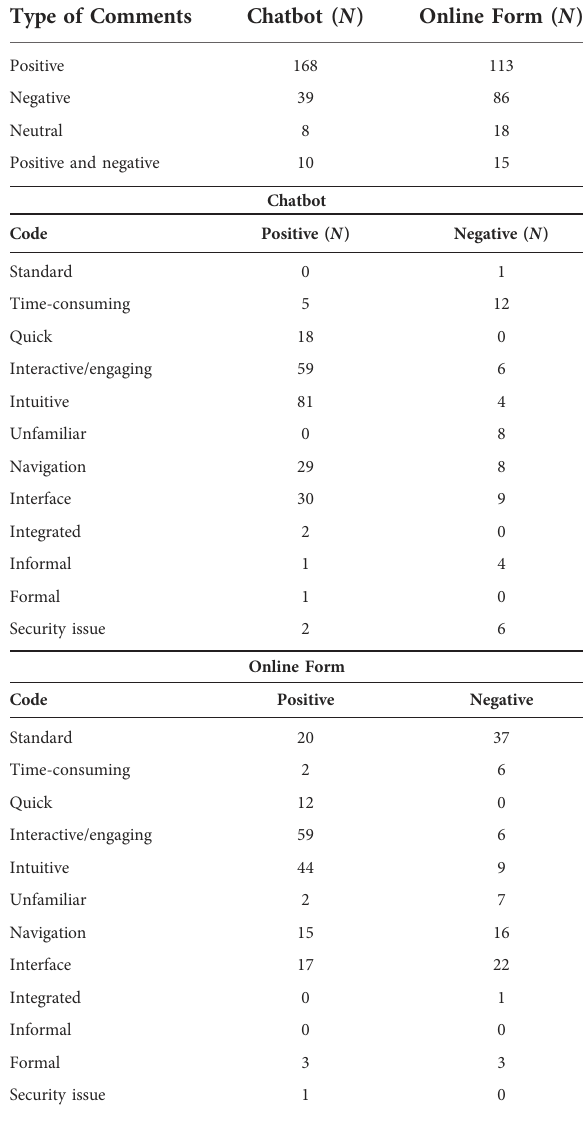
TABLE 6 Positive and negative perception resulting from complex coding